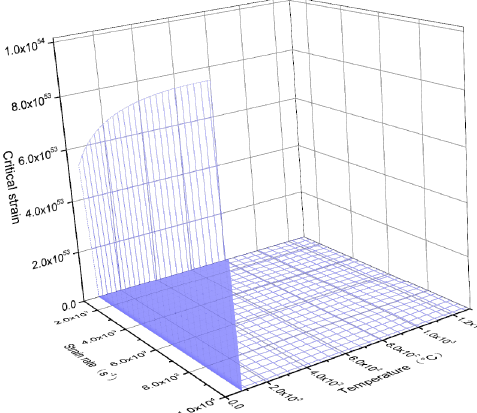
ff erent strain rate and Figure 11. Critical strain with different strain rate and temperature. Figure 11. Critical strain with di